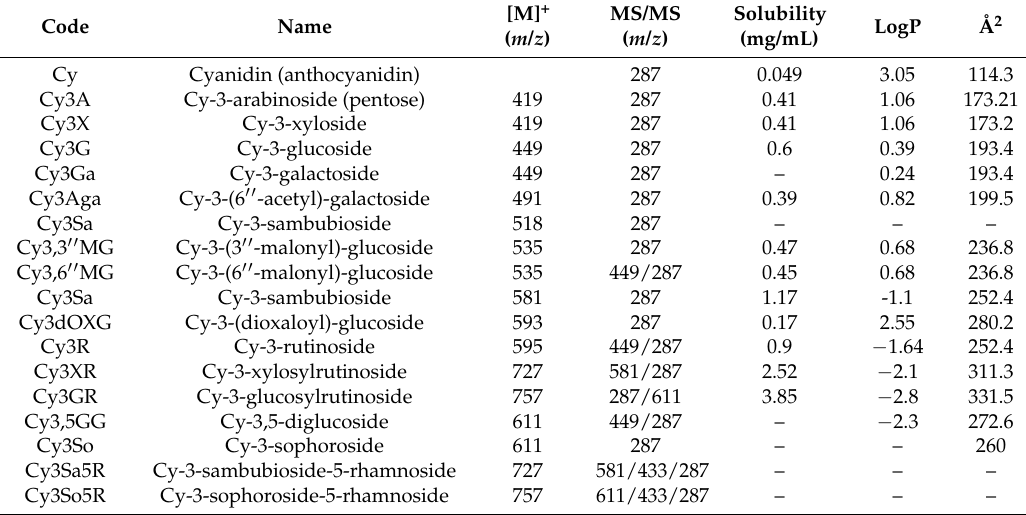
Table 1. Mass spectral data and physicochemical characteristics of Cyanidin (Cy) and glycoside-derivates 1